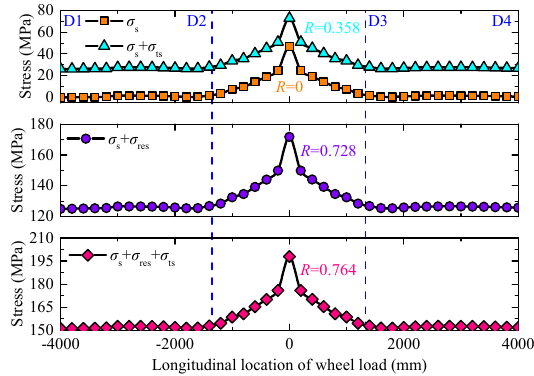
Figure 19. Stress wave at weld root under critical loading position.